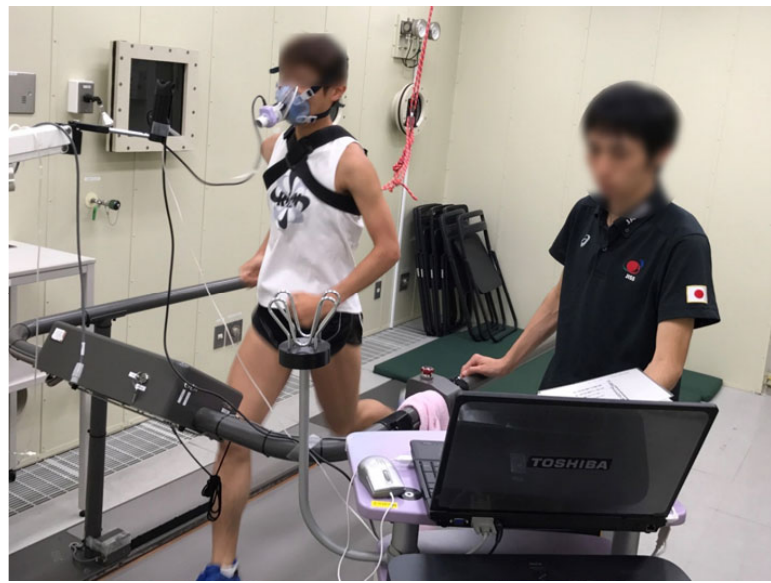
Figure 2. Indirect calorimetry using a face mask. Expired air was collected through a face mask, limiting the measurement duration to a few hours. The expired air was subjected to analysis of O 2 and CO 2 concentration.